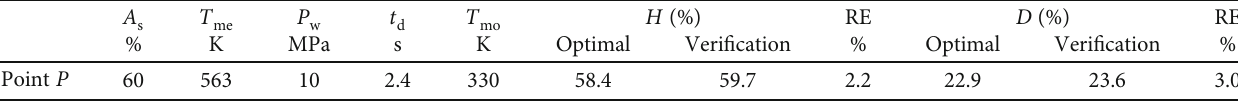
Table 4: Comparison between the best solution and the veri fi cation